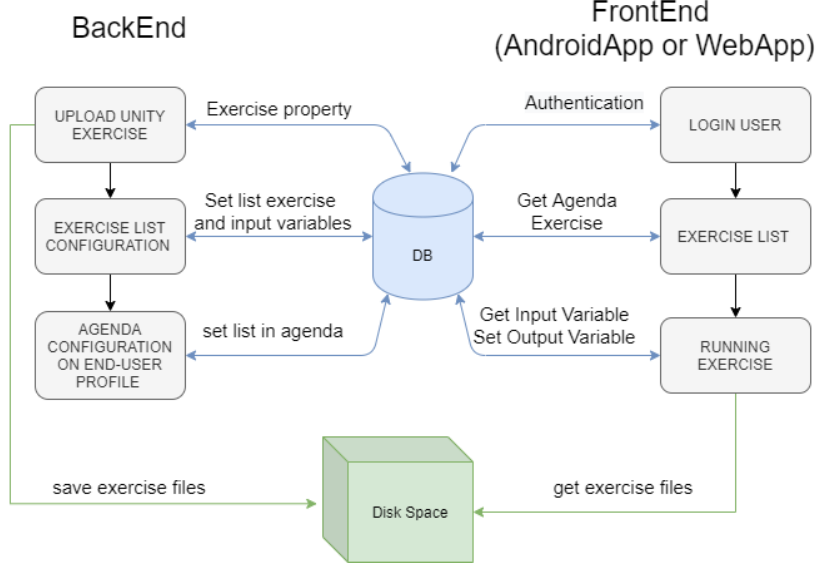
Figure 1. The architecture of the NU!Reha